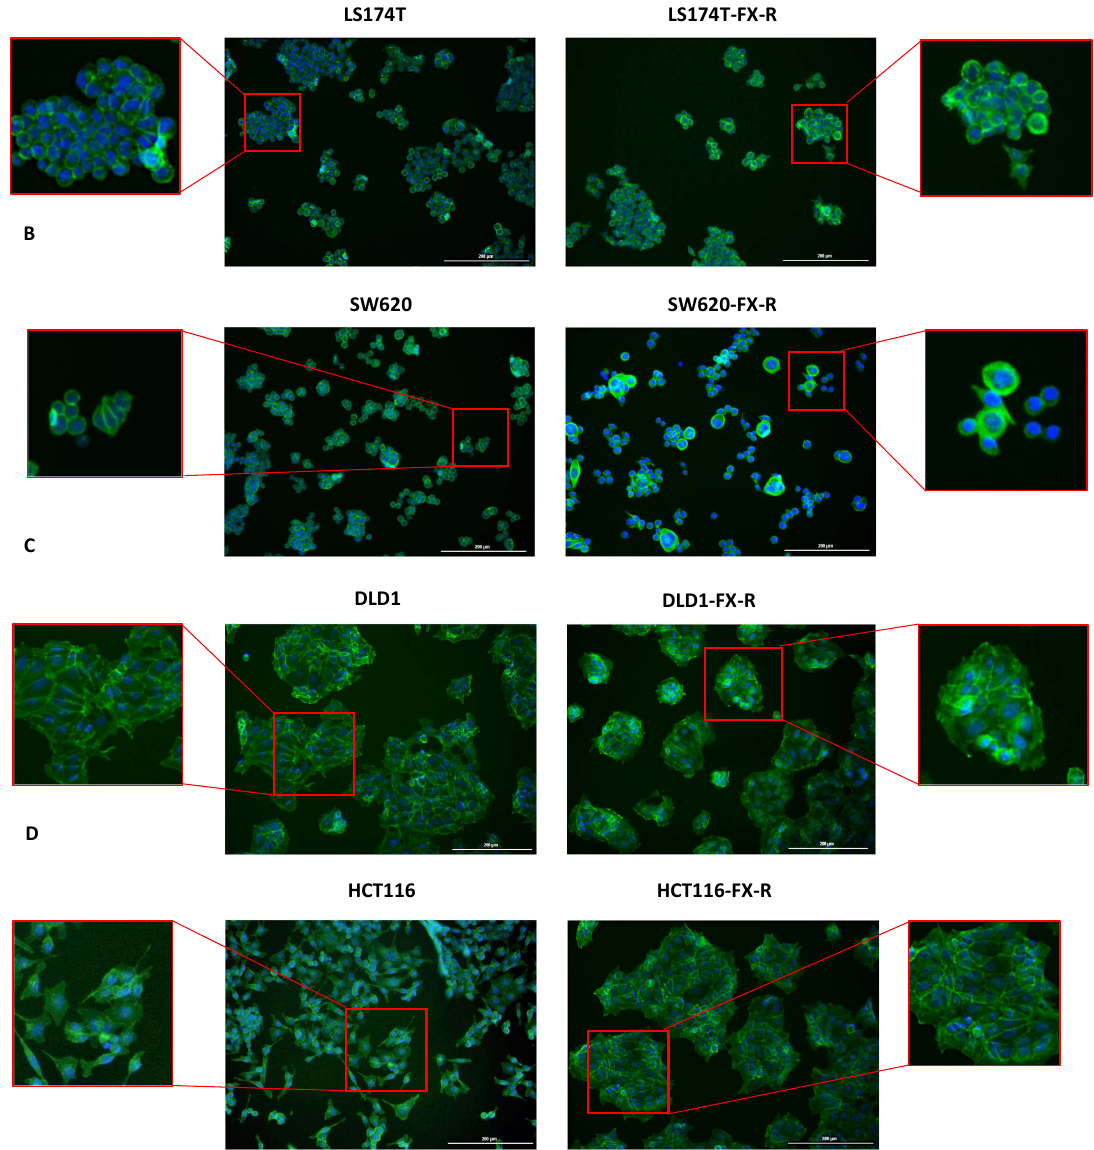
Figure 2. Morphology of FX-resistant and FX-naïve human CRC cells. Representative fluorescence images of FX-naïve and FX-resistant cells: LS174T ( A ) SW620 ( B ) DLD1 ( C ) and HCT116 ( D ) of DAPI (blue) and phalloidin (green) stained cells. n = 5. Scale bar = 200 µm.